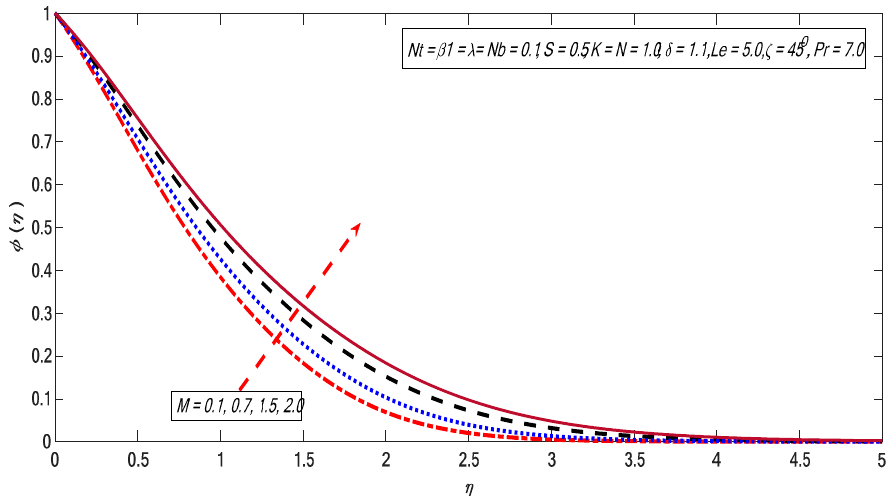
Figure 15. Variations in concentration profile for several values of 𝑀 . Appl. Sci. 2019 , 9 , x FOR PEER REVIEW